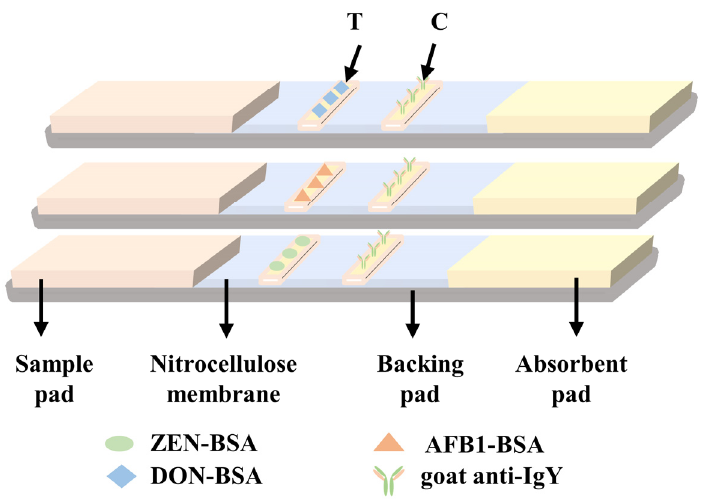
Figure 4. Schematic representation of the immunochromatographic test strip for AFB1, ZEN and